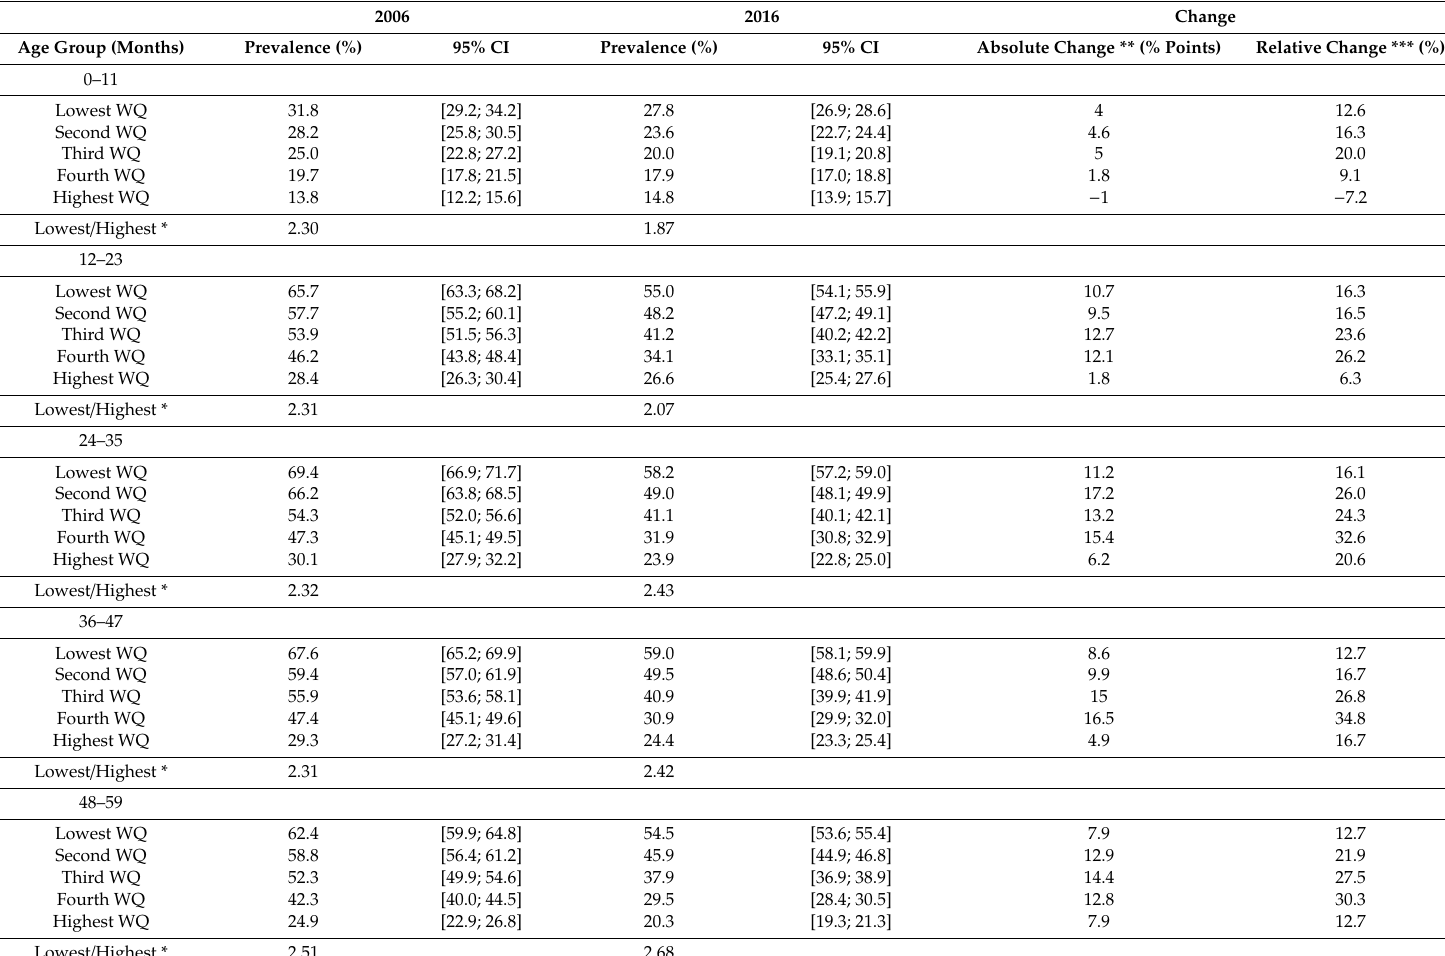
Table 2. Prevalence of child stunting by age groups and wealth quintiles, India, NFHS 2006, and